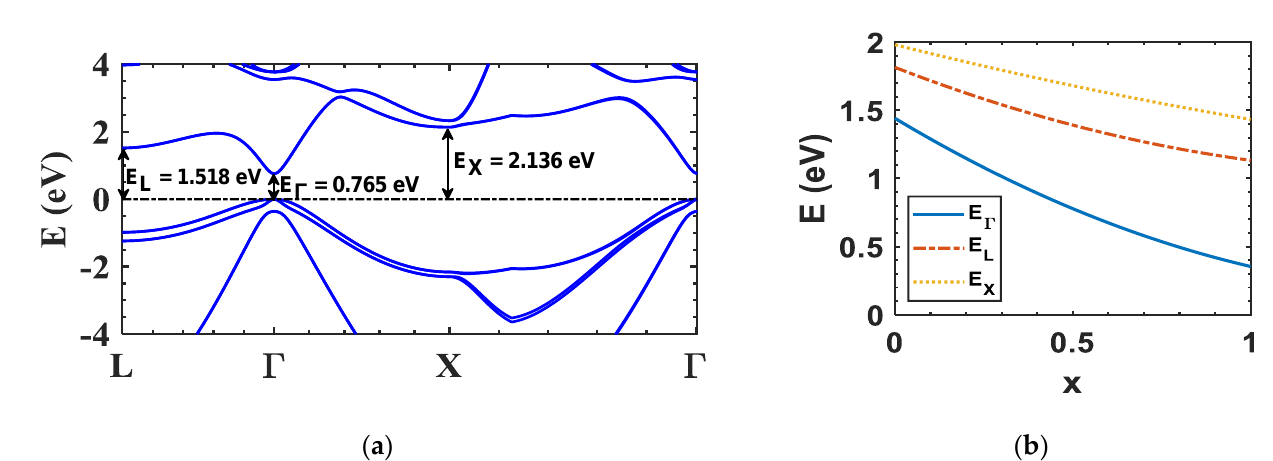
Figure 20. ( a ) Simulated bulk bandstructure of In 0.53 Ga 0.47 As; ( b ) energy level of the different valleys of In x Ga 1-x As as a function of x [30].